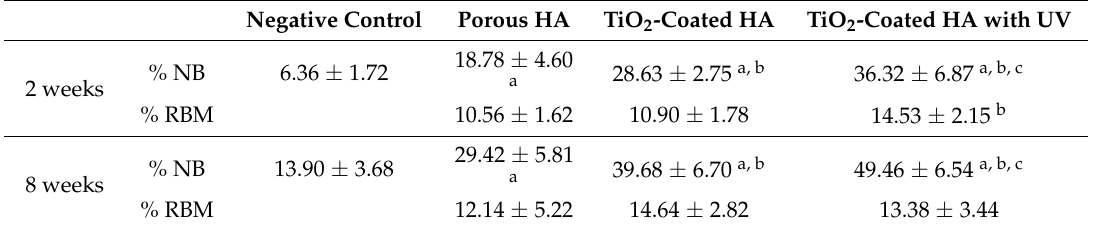
Figure 5. Histomorphometric evaluation of bone regeneration (intragroup analysis). In all groups, statistically significant intragroup differences in new bone formation were observed at two weeks and eight weeks. Data are presented as the mean ± standard error of the mean. * p < 0.05. Table 1. Histomorphometry. Mean ± standard deviation values for new bone (NB) and the residual bone material (RBM) as percentages within surgically created defects ( n = 12).